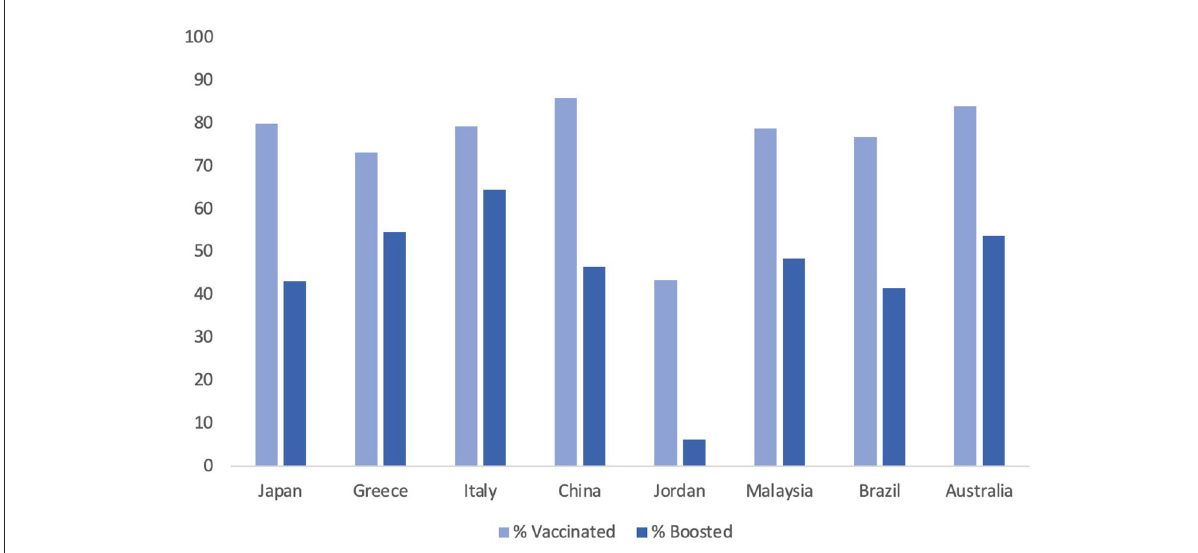
FIGURE1 A country specific visualization of COVID-19 vaccination and booster rates by December